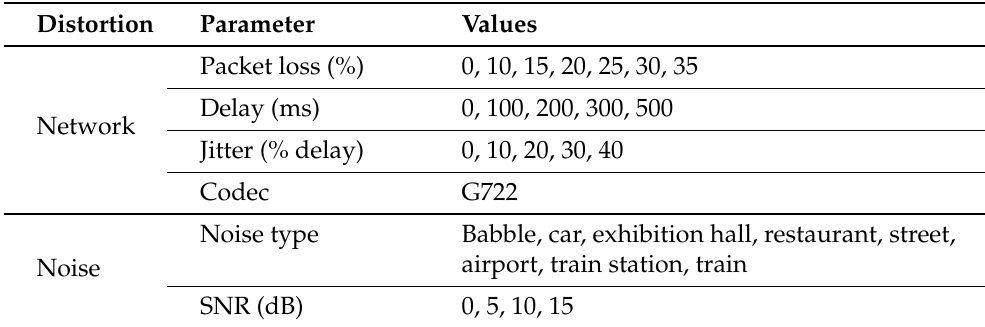
Table 1. Combined noise and network distortion